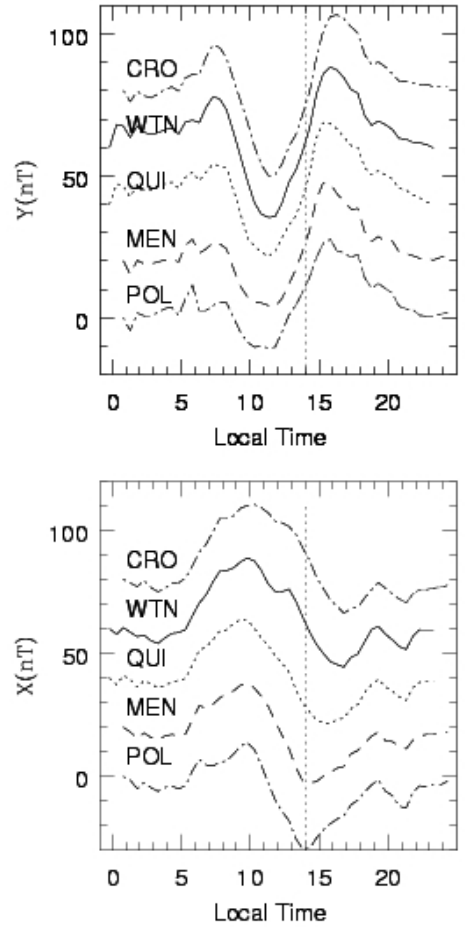
Fig 2. Variation of the hourly means of the northward and eastward magnetic components, X and Y, at Fig. 2. Variation of the hourly means of the northward and eastward a chain of stations on the east side of Australia on 2 June 1990. See Fig 3 for locations of stations. Each magnetic components, X and Y , at a chain of stations on the east side of Australia on 2 June 1990. See Fig. 3 for locations of stations. plot is adjusted to zero at midnight and the plots are displaced by 20 nT for easier viewing. The vertical Each plot is adjusted to zero at midnight and the plots are displaced dashed line indicates the time of passage of the focus. by 20nT for easier viewing. The vertical dashed line indicates the time of passage of the focus.